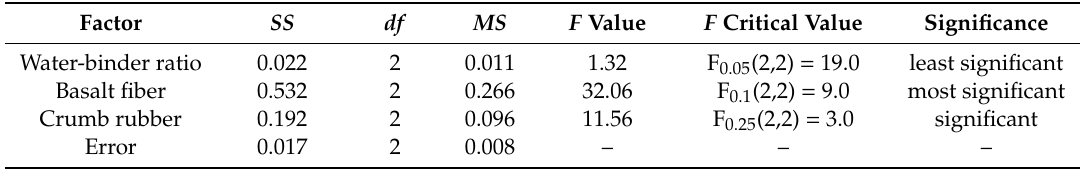
Table 11. Variance analysis for the flexural strength of CRBFC.